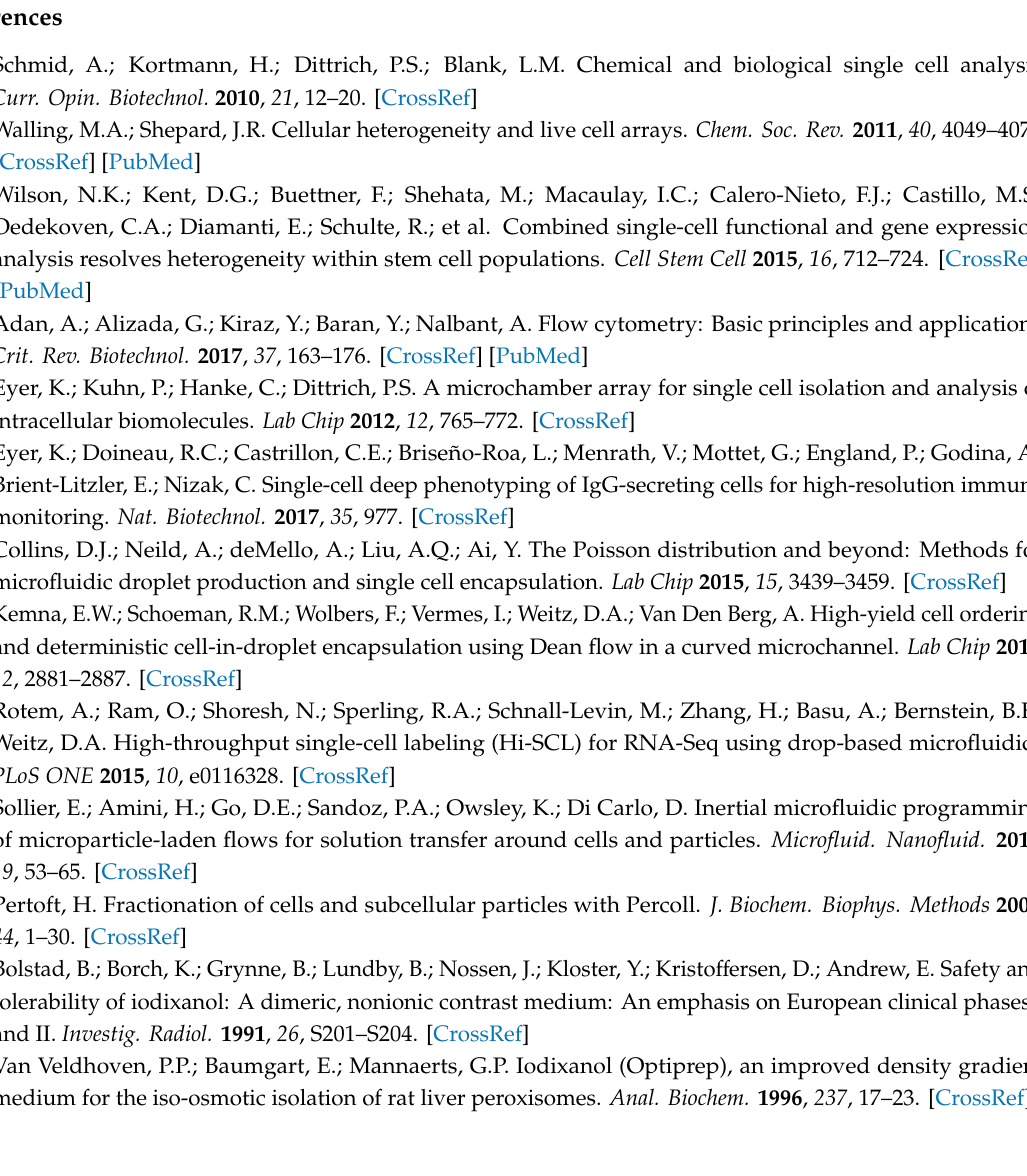
Figure S1: Photographs of the microfluidics chips and experimental setup, Figure S2: A photograph of droplets recognized by programs written by MATLAB, Figure S3: Actual images of cells encapsulated within microdroplets under di ff erent conditions, Figure S4: A photograph of cell sedimentation at the inlet of a microchannel, Figure S5: Plots of Poisson distribution for droplets of three di ff erent sizes, Table S1: Poisson statistics for di ff erent cell concentrations and droplet sizes, Table S2: Data collected from captured images of cell-laden droplets. The data obtained from three duplicates are shown, Table S3: Data collected from viability test. The data obtained from three duplicates are shown. Video S1: Droplet formation at the T-junction of a microfluidic droplet